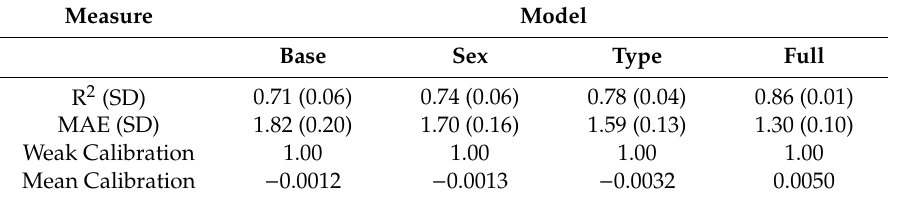
Table 2. Performance measures for all models. SD = standard deviation, MAE = mean absolute error.